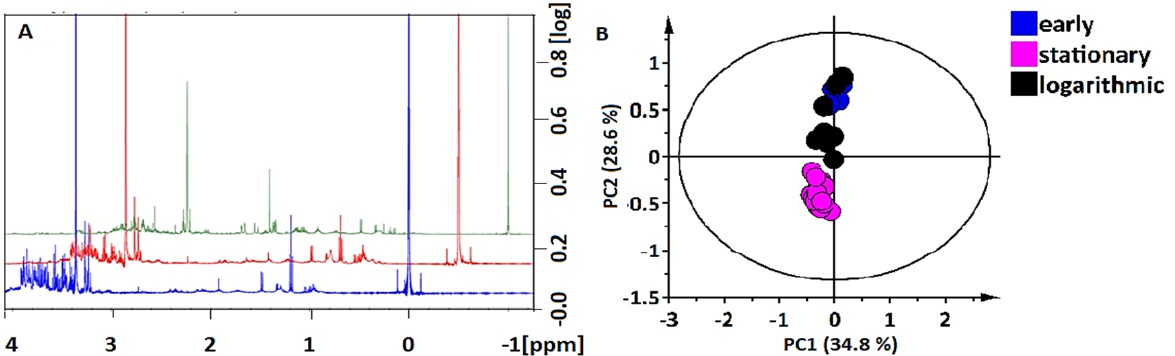
Figure 3. ( A ) 1 H NMR spectra (500 Hz) of intracellular metabolites present in methanolic extracts of H. roseonigra . The cells were harvested from selected days (0, 4, 6, 10, 14 d) over a 14 d period representing the different growth stages, i.e., early- (blue line), logarithmic- (red line), and stationary (green line). The representative spectra show evident differences in peak intensities across the different days, where the intensities decrease or increase for some peaks. The resonance from the internal standard (TSP) is at 0.00 ppm. ( B ) Multivariate data analysis showing a representative principal components analysis (PCA) scores plot. The plots, constructed from the first two components, show clustering according to different developmental stages represented as early-, logarithmic-, and stationary with gradual overlap between the early- and log stages. The Pareto -scaled 2D scores plot with PC1 and PC2 showing 34.8% and 28.6%, respectively, explaining a total variation of 63.4%.